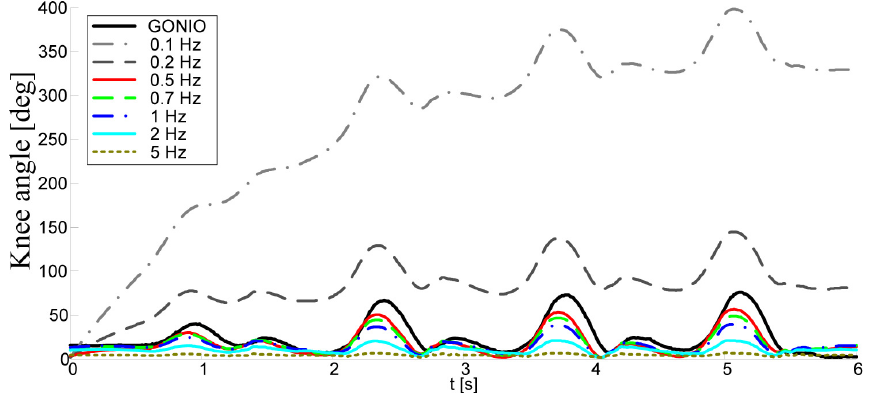
f on angle estimation: filtering for several cutoff frequencies Figure 5. Influence of 0 compared with angle acquired from